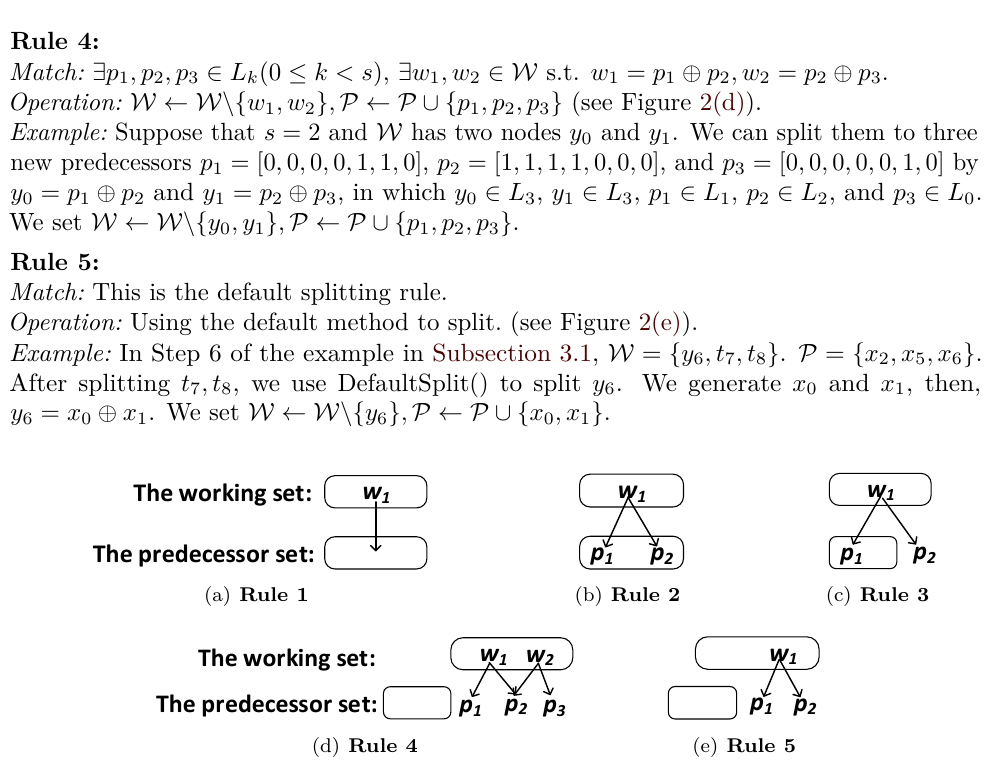
Figure 2: The different splitting